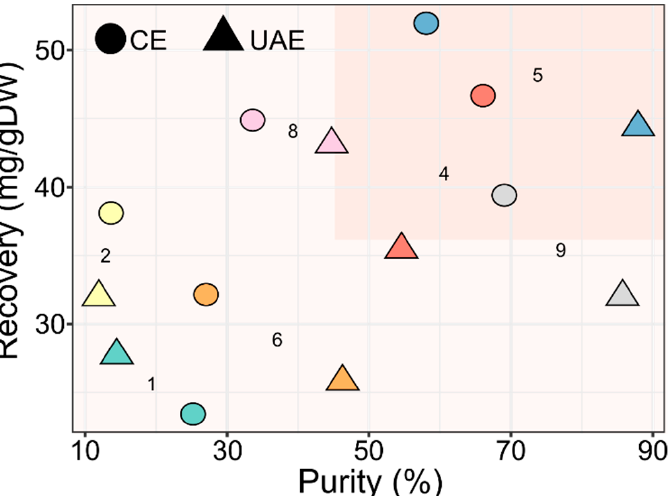
Figure 4. Purity–recovery graph for MPTOX extraction. Purity is expressed as percentage (%), recovery as milligrams for gram of dry weight (mg/g DW). In the top-right section, extractions above the average with the solvent employed are shown.